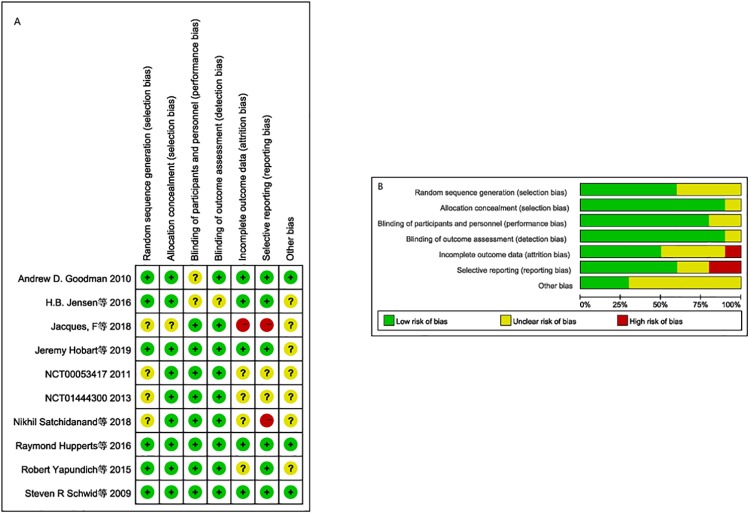
A is the graph of risk of bias summary; B is the graph of risk of bias.